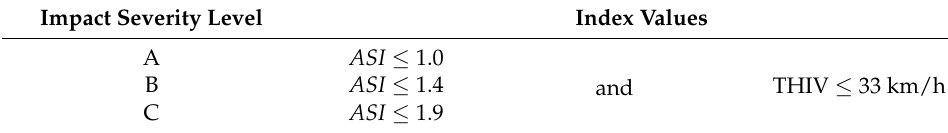
Table 4. Impact severity limits of safety barriers according to EN 1317-2